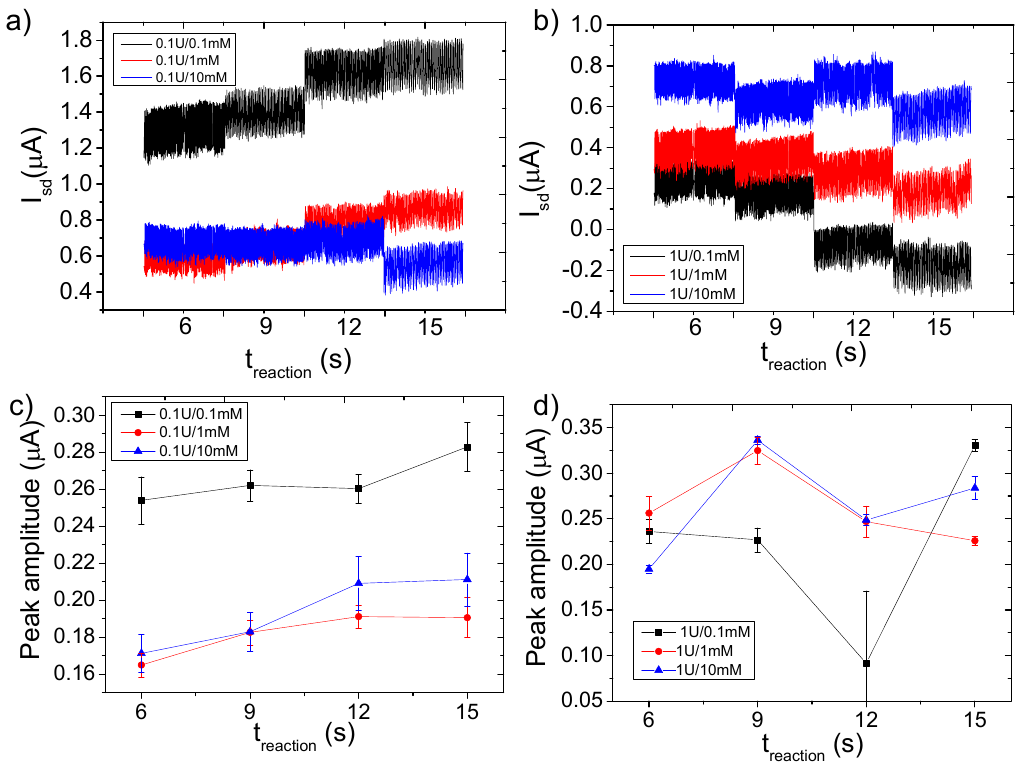
Figure 4. Data obtained from the assay with the subtracted effect of streaming potential. ( a ) Reaction with increasing substrate concentration and constant enzyme concentration at ( a ) 0.1 U and ( b ) 1 U. The reaction was detected at four time points. ( c ) and ( d ) show the averaged data from each respective set of experiments, calculating the difference between the maxima and minima of the peaks.